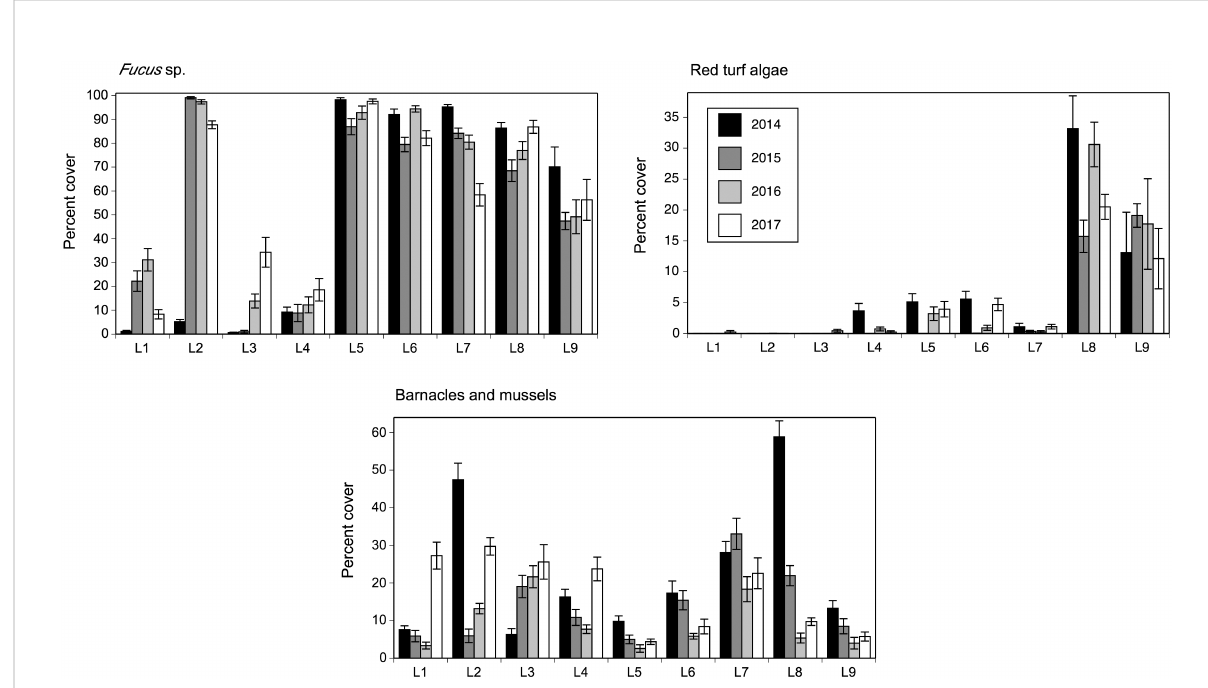
FIGURE 7 Percent cover (mean ± SE) of the sessile species that had the largest contribution to the multivariate patterns for sessile species as revealed by SIMPER